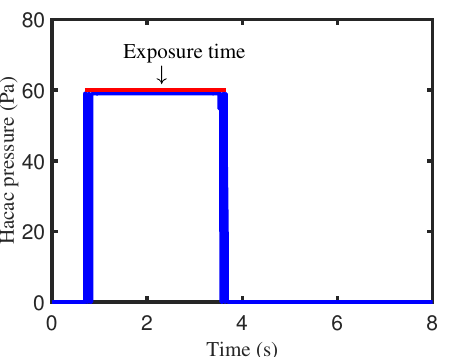
Figure 7. Hacac partial pressure over time on a node in the mesh. As the wafer rotates, the pressure rises around 0.8 s to reach the plateau and goes to 0 around 3.6 s. The length of the straight line in red is defined as the exposure